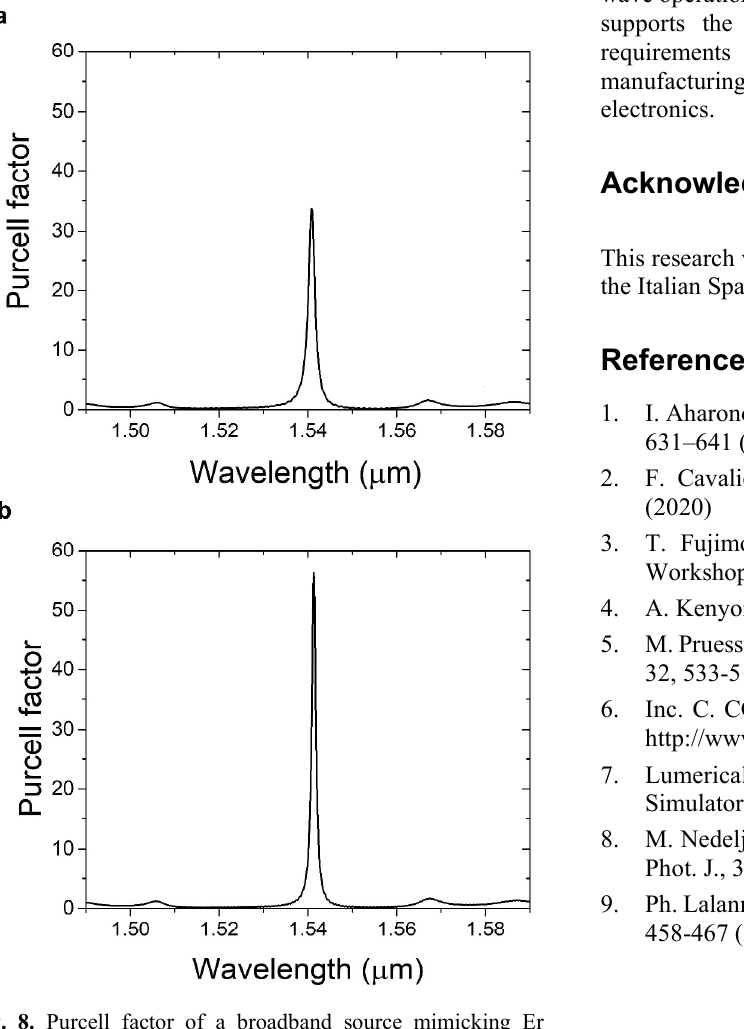
Fig. 8. Purcell factor of a broadband source mimicking Er emission for a cavity length of 344 nm (upper plot) and 644 nm (lower